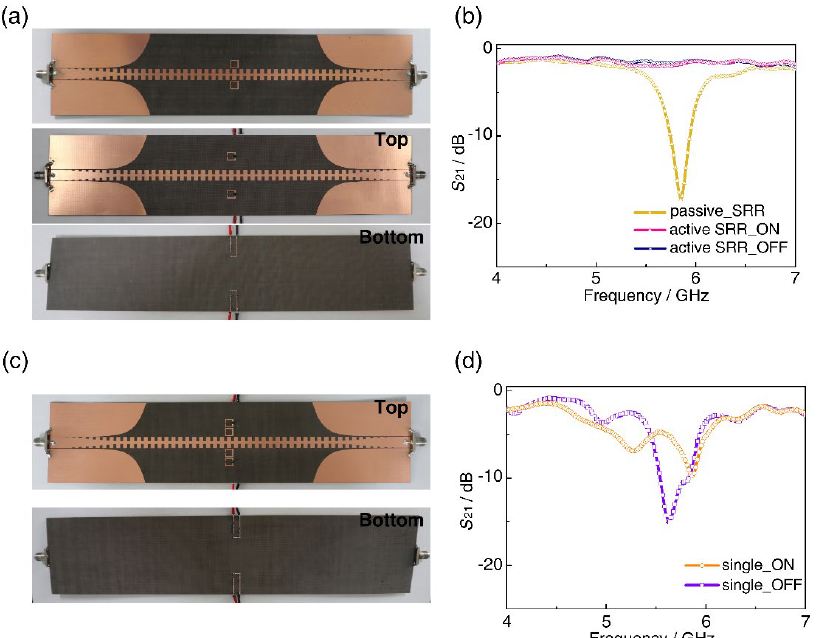
Figure 4. Experimental measurements of tunable EIT-like behavior in SSPP waveguide. ( a ) Photograph of fabricated SSPP waveguide samples loaded with single set of passive SRRs and active SRRs in top and bottom views. ( b ) Transmission coefficients corresponding to structures in ( a ). ( c ) Photograph of fabricated SSPP waveguide sample loaded with single set of EIT modules in top and bottom views. ( d ) Transmission coefficients corresponding to structures in ( d ). The word in Figure (a,c) indicates the top and bottom views, respectively.